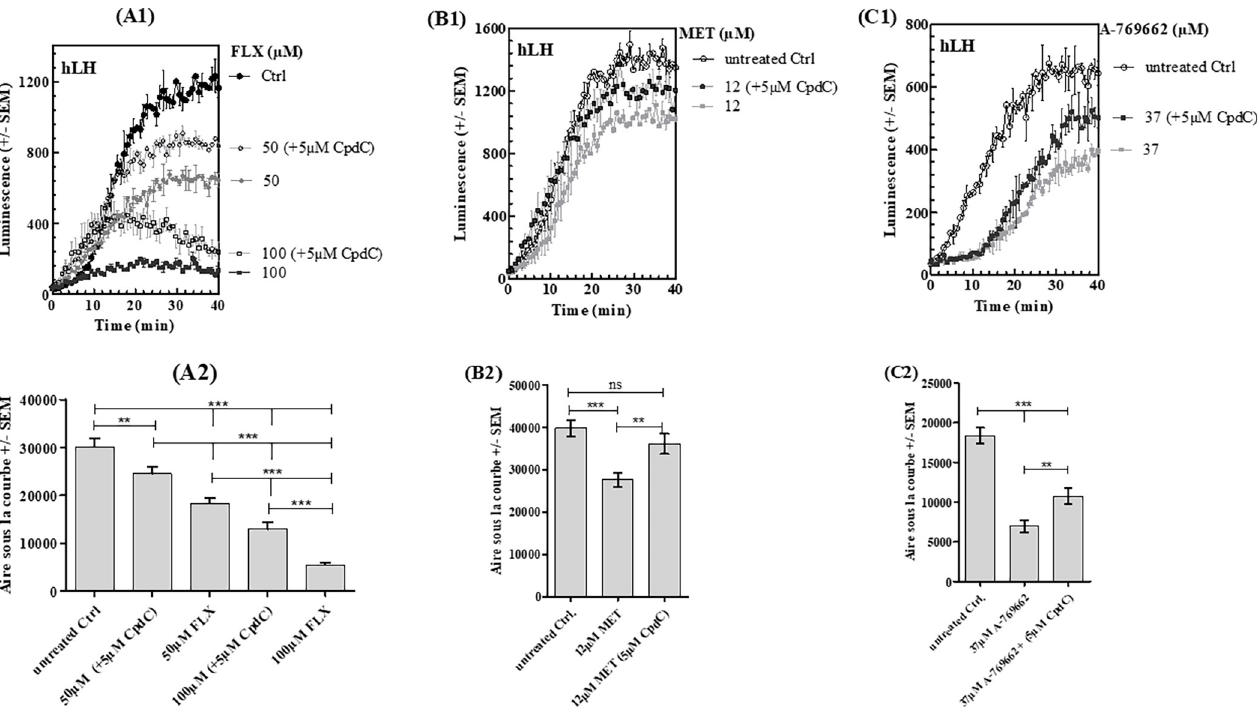
Fig 7. Effect of Compound C on FLX, MET, or A-769662 on intracellular cAMP response of MLTC-1 cells to hLH. (A1), (B1), (C1) Real-time recording of luminescence under stimulation of MLTC-1 cells by hLH in presence of FLX, MET, or A-769662. (A2), (B2), (C2) Dose-dependent response to FLX, MET, or A-769662 determined by the Area Under Curve (AUC) of individual kinetics in figs A1, B1 and C1 respectively. Data represent mean ± SEM of 3 independent experiments (n = 3). Results were analyzed by one-way ANOVA, followed by the Dunnett’s test posttest). � : significant difference ( �� p < 0.01; ��� P < 0.001), ns: no significant